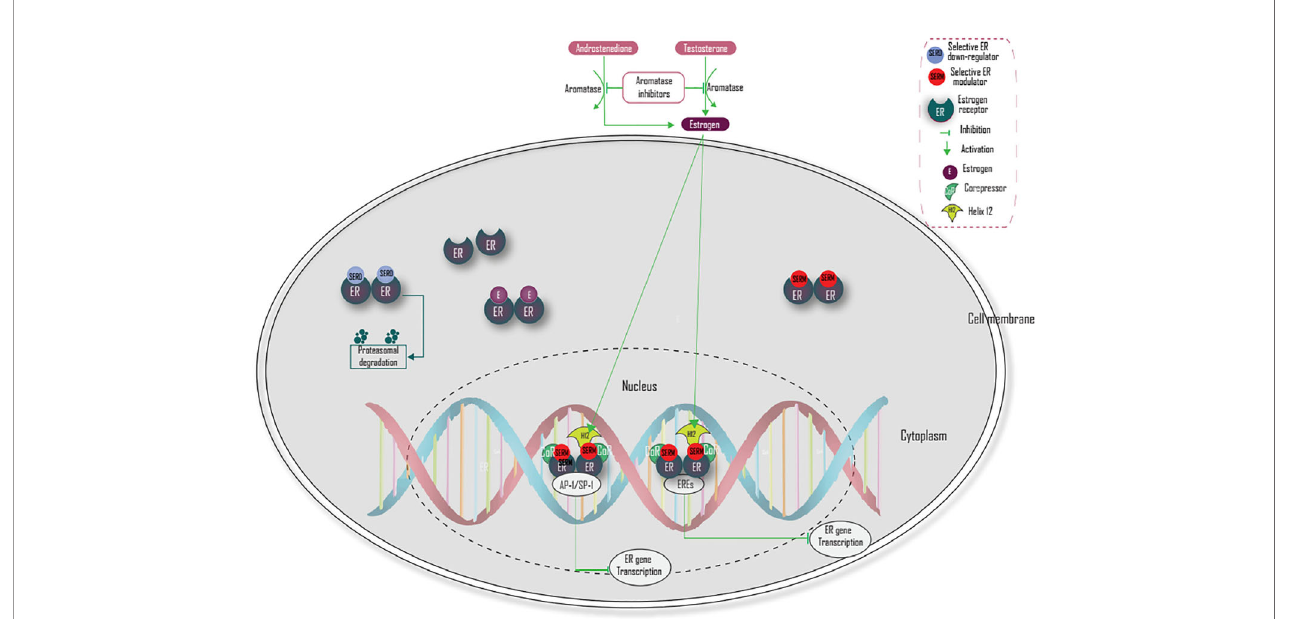
FIGURE 3 | Mechanisms of action of main endocrine